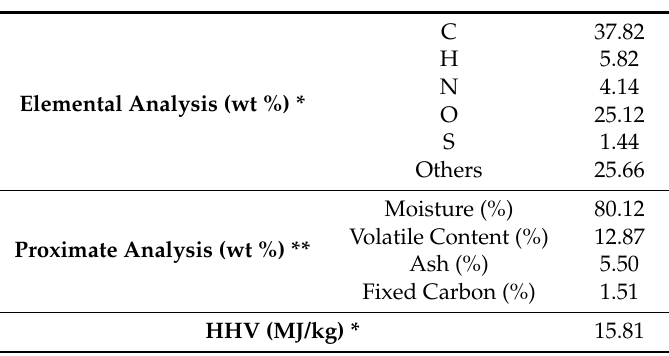
Table 1. Properties of raw sewage sludge.